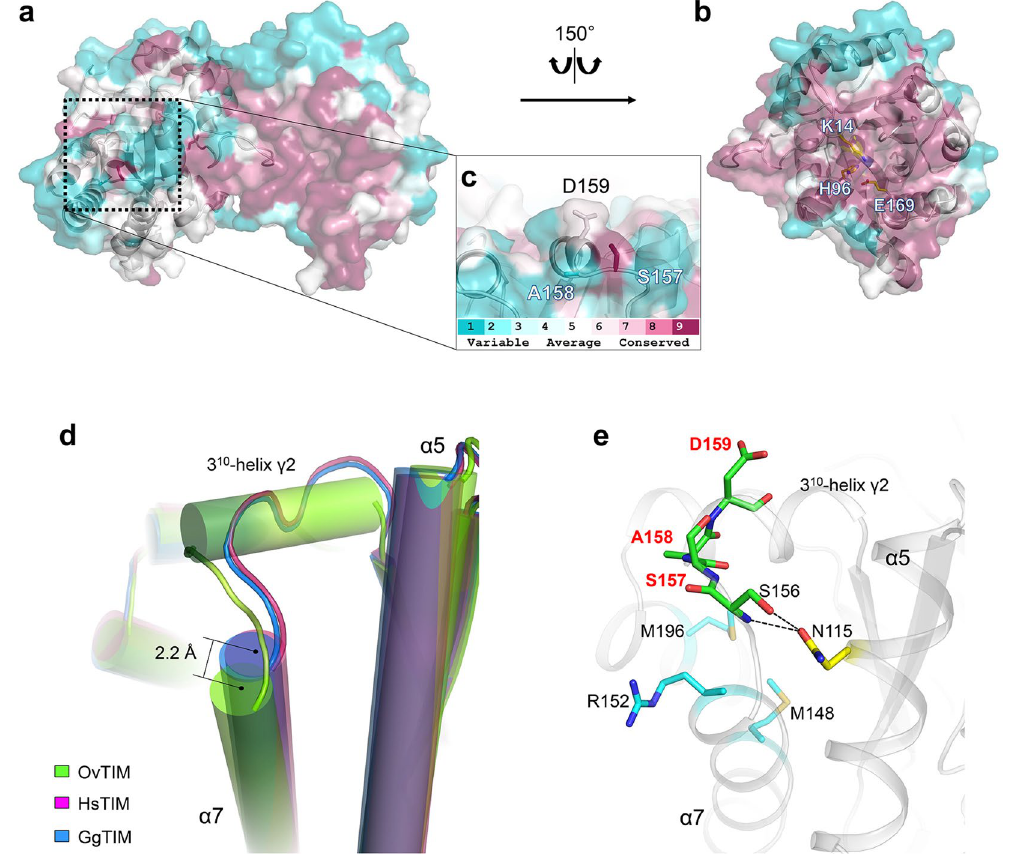
Figure 2. Structural analysis of SAD motif. ( a ) Degree of residue conservation of TIM among 7 parasitic trematodes ( O. viverrini (accession code: A0A074Z863), Clonorchis sinensis (accession code: G7YDG0) , Schistosoma haematobium (A5A6F9) , Schistosoma japonicum (Q27775) , Schistosoma mansoni (P48501) , Schistosoma turkestanicum (Q45XG1), and Taenia solium (Q9GTX8)) is represented as color variations in a surface model from cyan (lowest conserved residue) to wine (highest conserved residue). ( b ) Rotated view of the OvTIM monomer is shown, and residues forming the catalytic triad are represented as yellow sticks. ( c ) An enlarged view of the SAD motif. ( d ) Superimposition of OvTIM ( green ) structure with Homo sapiens TIM (PDB code: 4POC) and Gallus gallus TIM (GgTIM) (PDB code: 8TIM) is represented in magenta and blue , respectively. The corresponding region of the SAD motif in OvTIM is designated as dark green . ( e ) The intermolecular interaction of the region around the SAD motif. The bulky side chains are highlighted as a cyan stick